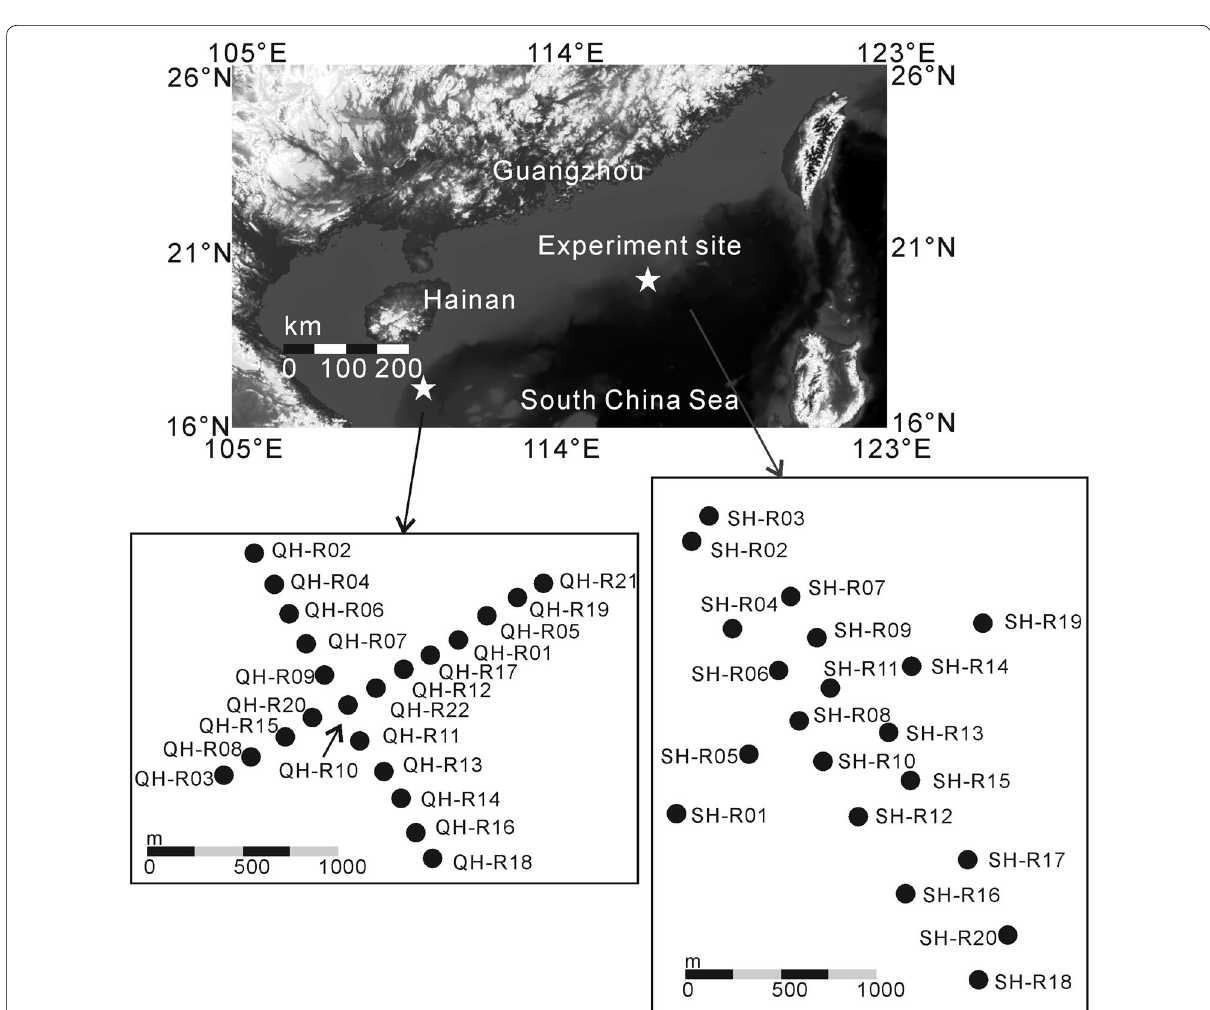
Fig. 1 Locations of marine CSEM and MT stations deployed in the Qiongdongnan (left) and Shenhu (right) areas of the South China Sea. The top panel shows a partial regional map of the South China